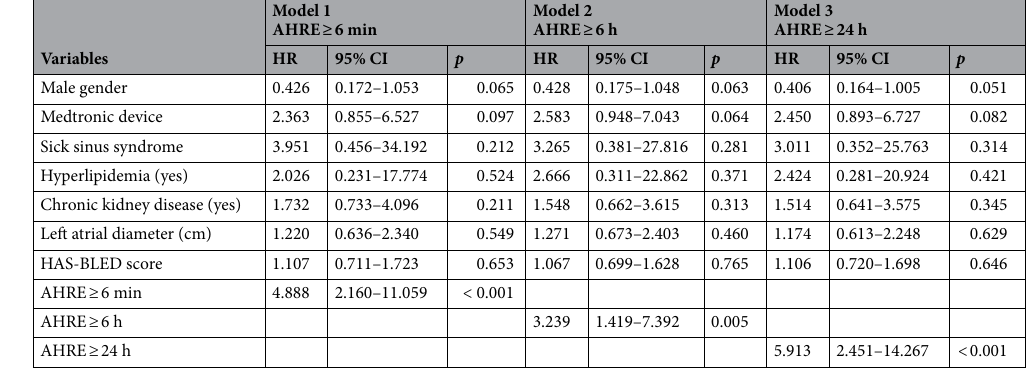
Table 4. Multivariate logistic regression analysis for independent factors of subsequent atrial fibrillation.